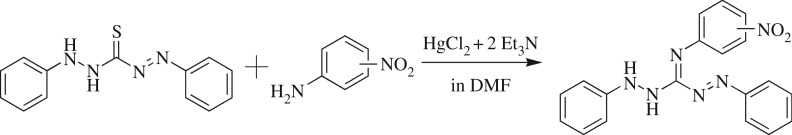
Reaction for the synthesis of test molecules: UA1 (nitro group is at meta position), UA6 (nitro group is at ortho position) and UA7 (nitro group is at para position).